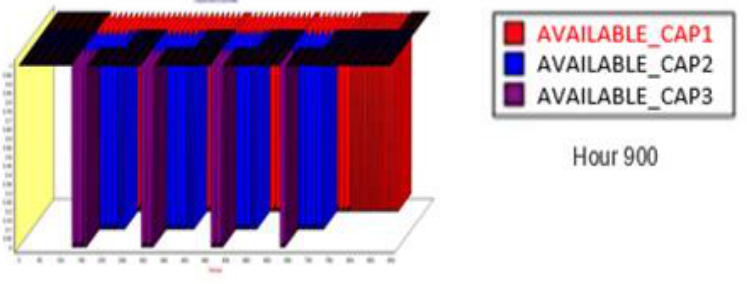
Figure 17. Available capacity comparison from the established scenarios. Source: own elaboration. Simulation results obtained from Evolution software.